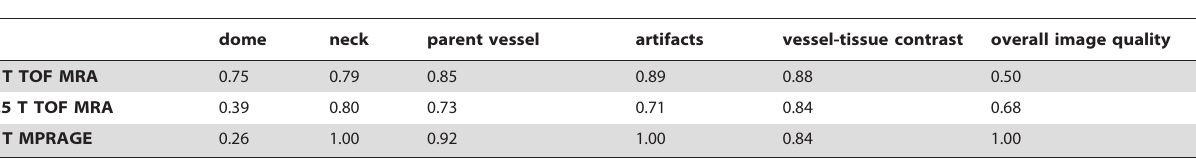
Table 2. Interobserver accordance (kappa-statistic).